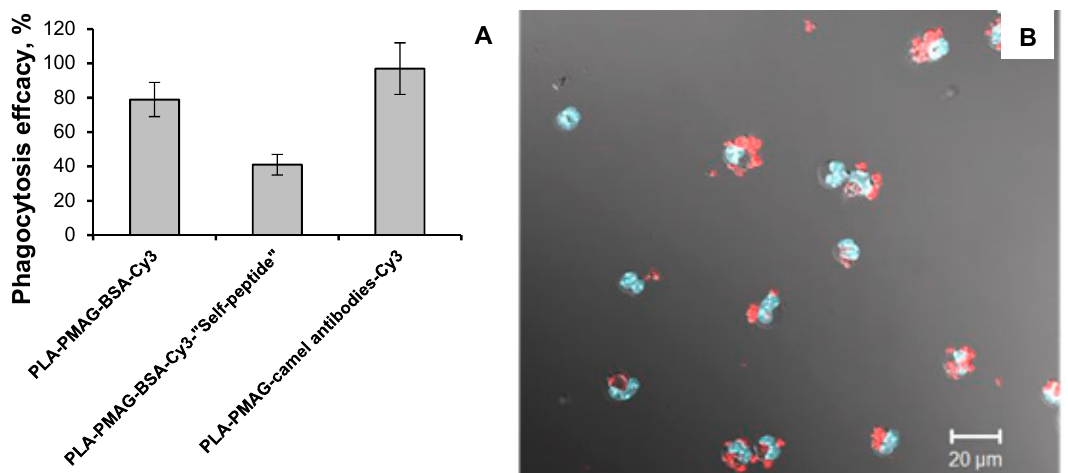
Figure 12. Results of phagocytosis of functionalized PLA nanoparticles: ( A ) Phagocytosis efficacy found for particles modified with different biomolecules; ( B ) image illustrating the phagocytosis process.